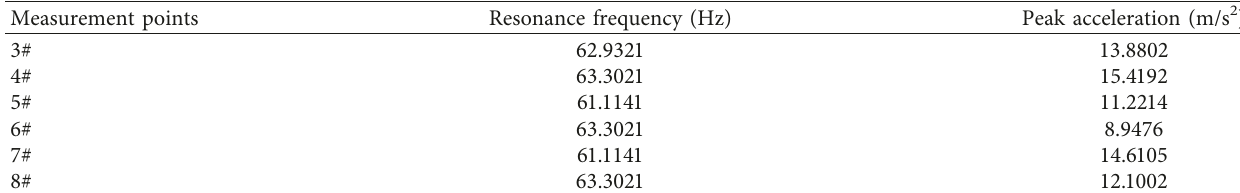
Table 9: 1# test piece resonance point information.